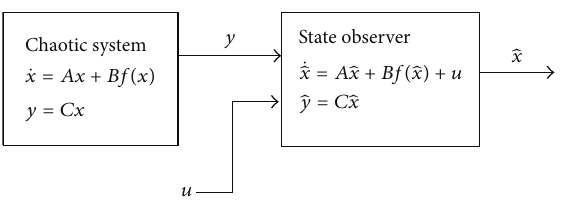
Figure 1: Adaptive state observer design.